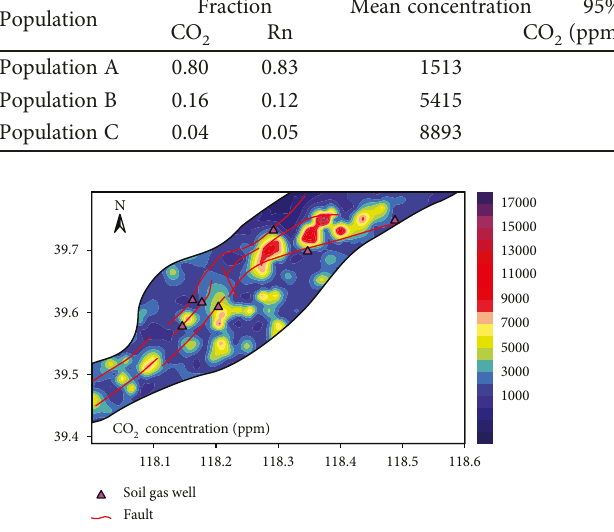
Figure 6: A contour map of soil gas CO sampling points.